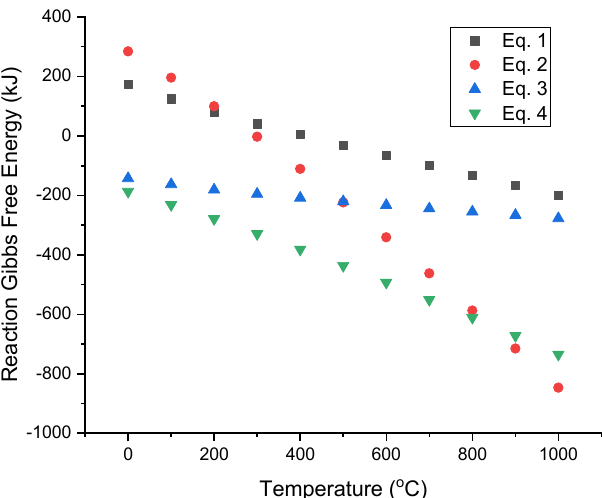
Figure 3. The change of the Gibbs Free Energy value with temperature in the reaction of the AgNO 3 salt with hydrogen and nitrogen.